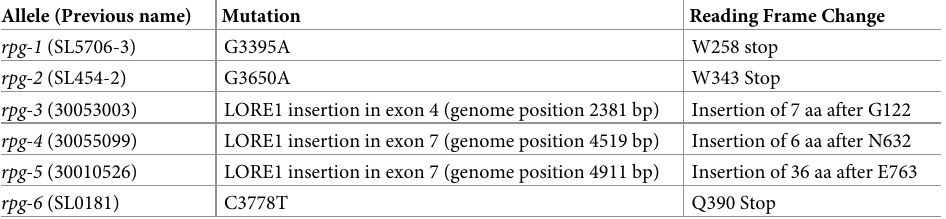
Table 1. L . japonicus rpg mutant